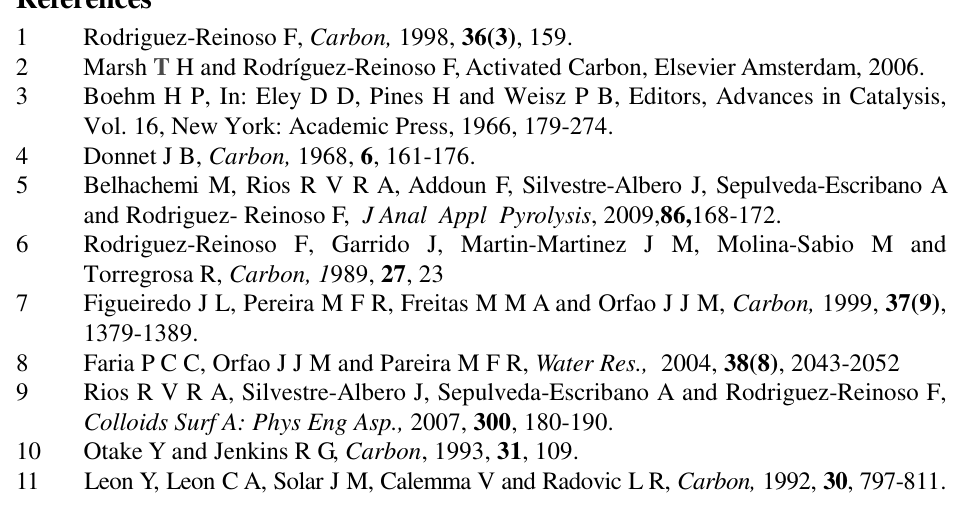
Figure 3. Evolution profiles of CO and CO S49N) and heat treated (C50NT and S49NT)